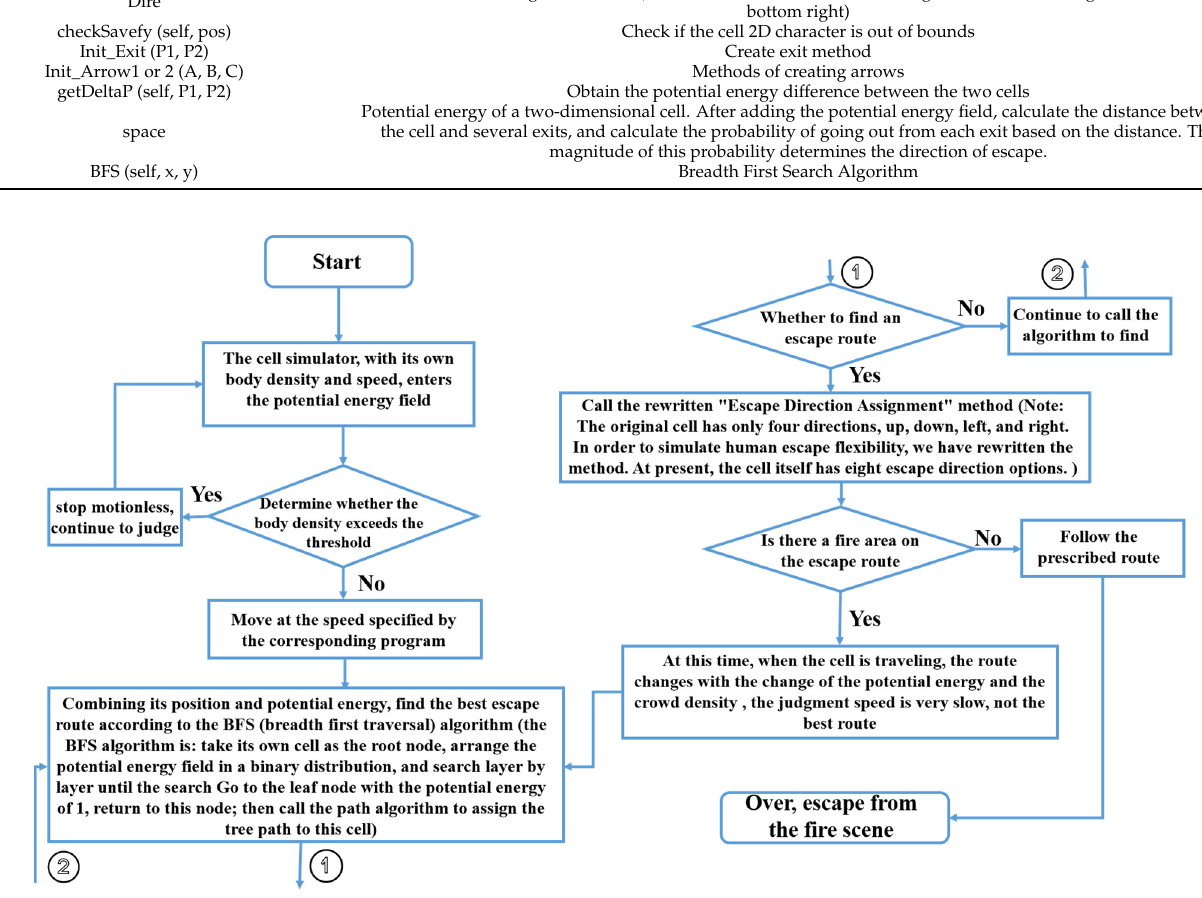
Figure 10. The evacuation flowchart of improved cellular automata.